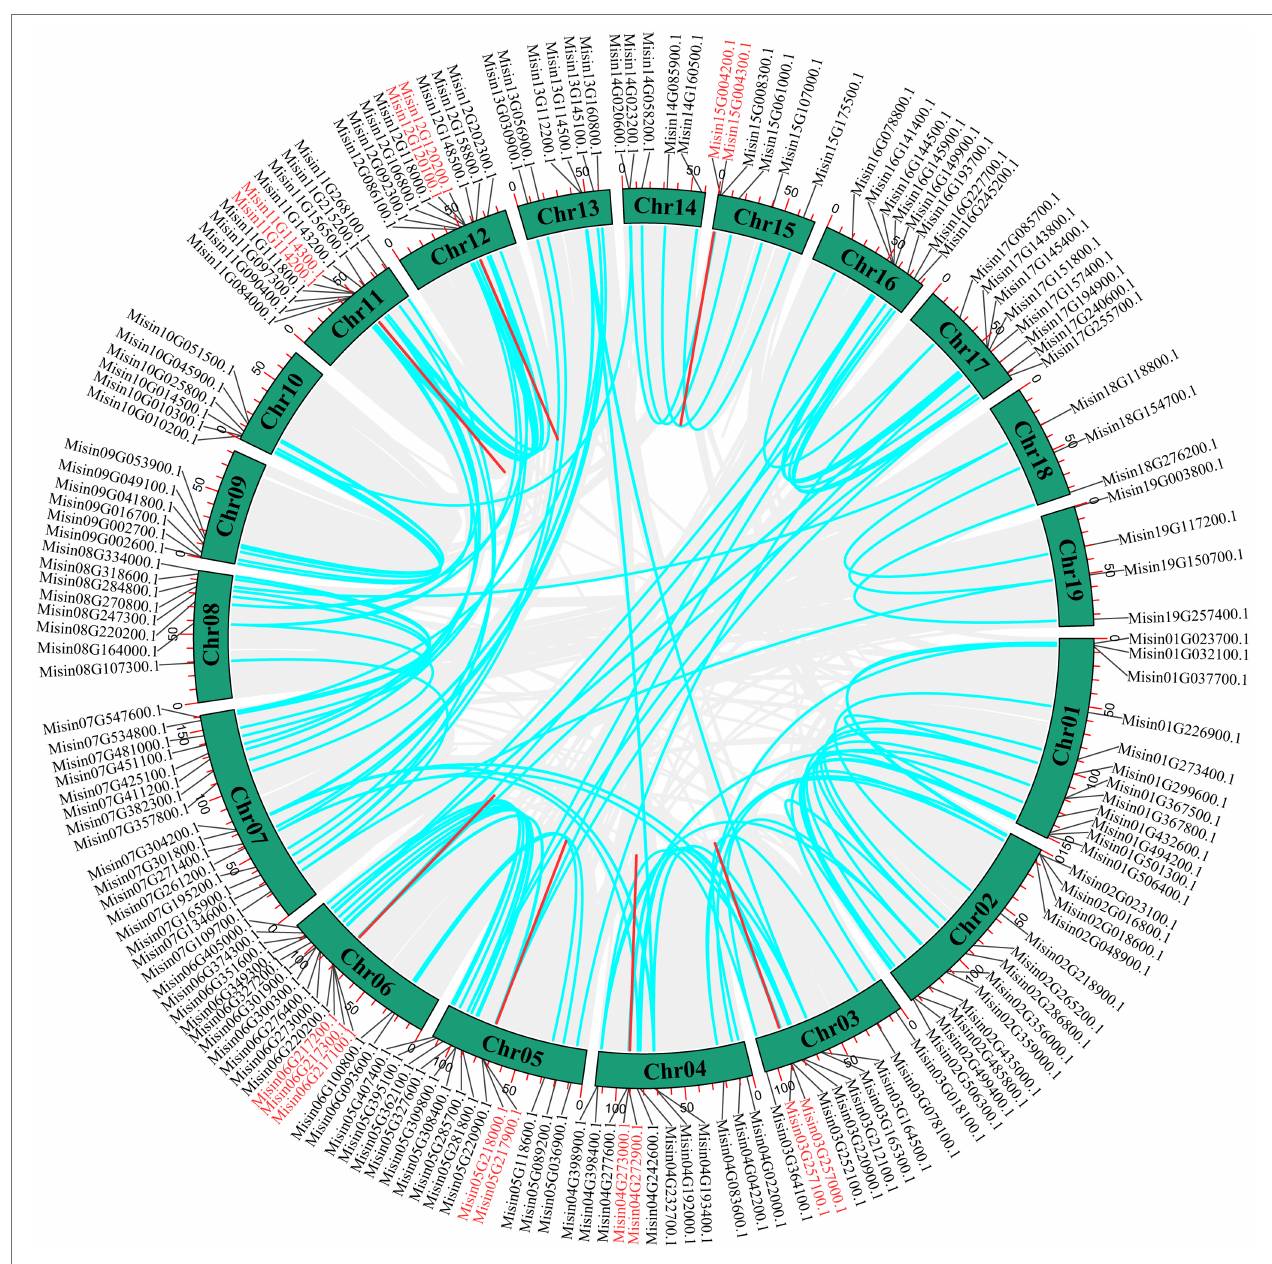
FIGURE 4 | Schematic representations of the interchromosomal relationships of M. sinensis NAC genes. Gray lines indicate all synteny blocks in the genome, and the blue lines indicate segmental duplicates of NAC gene pairs, and the red lines indicate tandem duplications of NAC gene